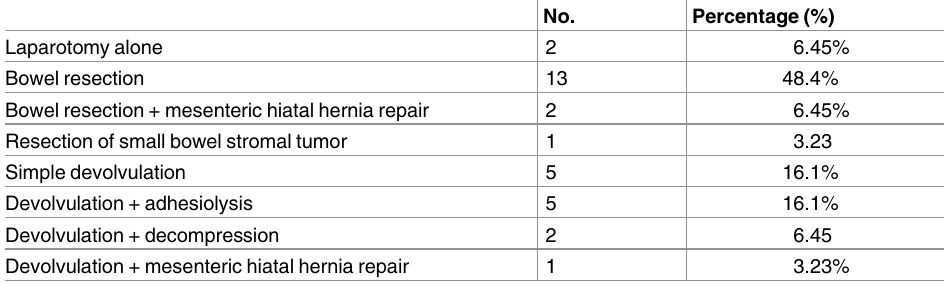
Table 4. Surgical procedures performed in the 31 patients.